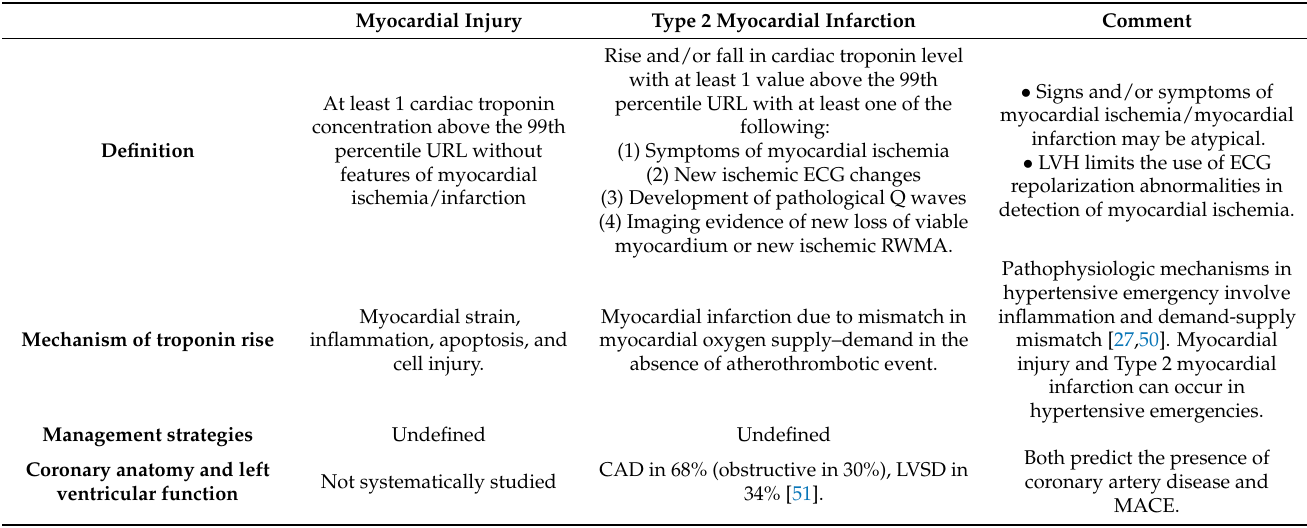
Table 3. Comparison of myocardial injury with Type 2 myocardial infarction (modified from